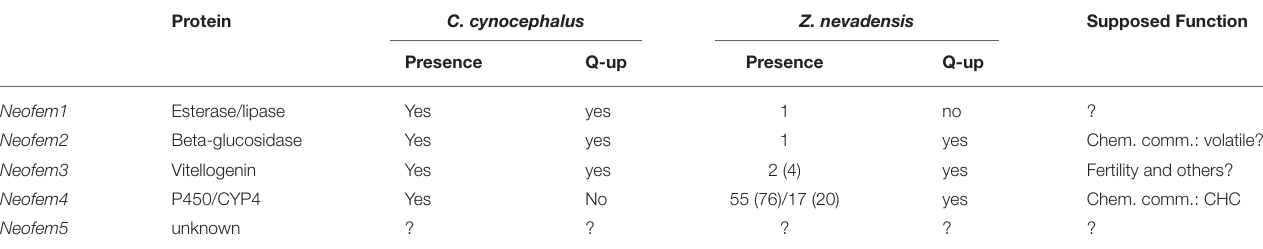
TABLE 1 | Neofem genes and their distribution across termites.